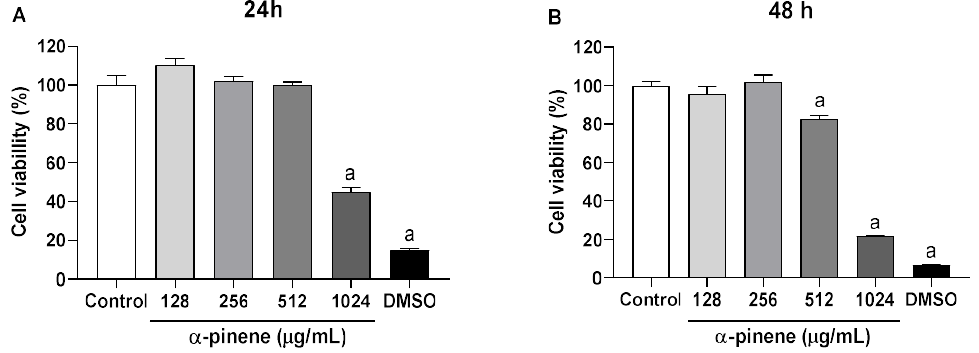
Figure 4. Cytotoxicity of α -pinene against human cell line HaCaT at 24 and 48 h. ( A ): Cell viability after 24 h of α -pinene treatment. ( B ): Cell viability after 48 h of α -pinene treatment. Data were analyzed with GraphPad Prism 8.0 software and presented as the mean ± SEM of three independent tests performed in quadruplicate. Significant difference ( p < 0.05) when compared to drug-free growth control (a).